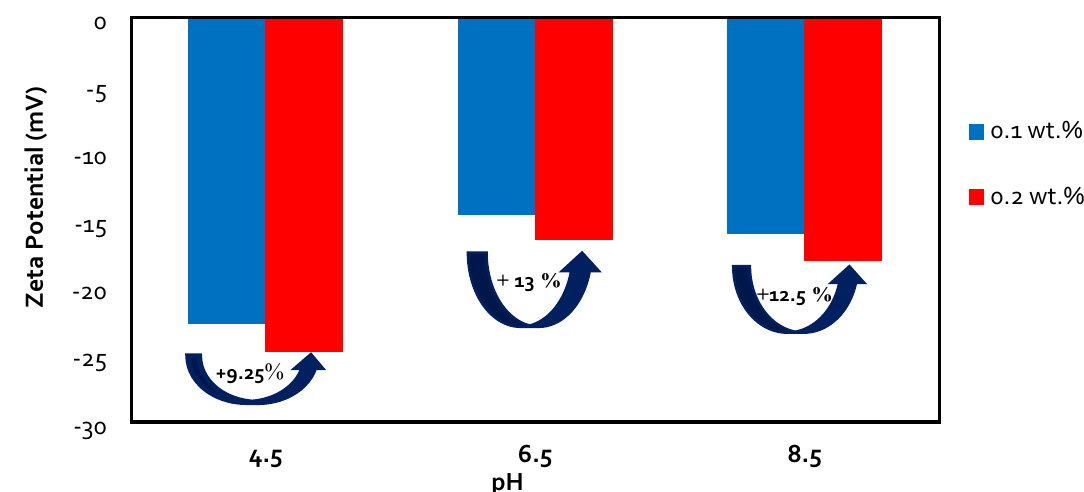
Figure 9. Effect of pH changes on ZP values in optimum diluted seawater (SW#10D) in the presence of silica NPs with different